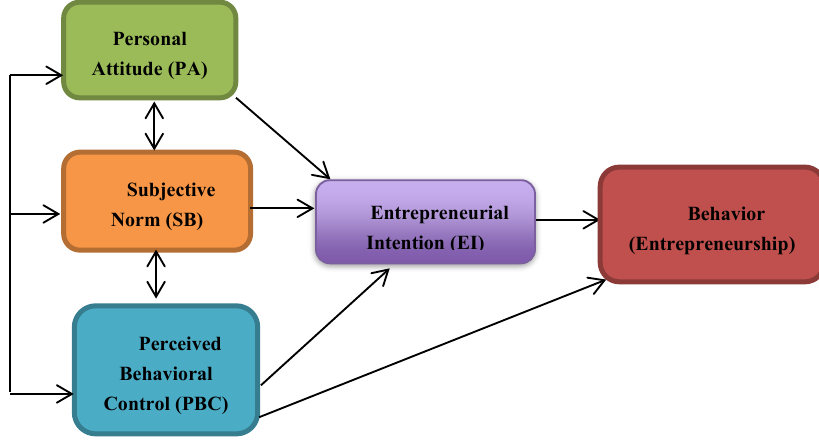
Fig. 1. Components of Ajzen’s planned behavioural theory